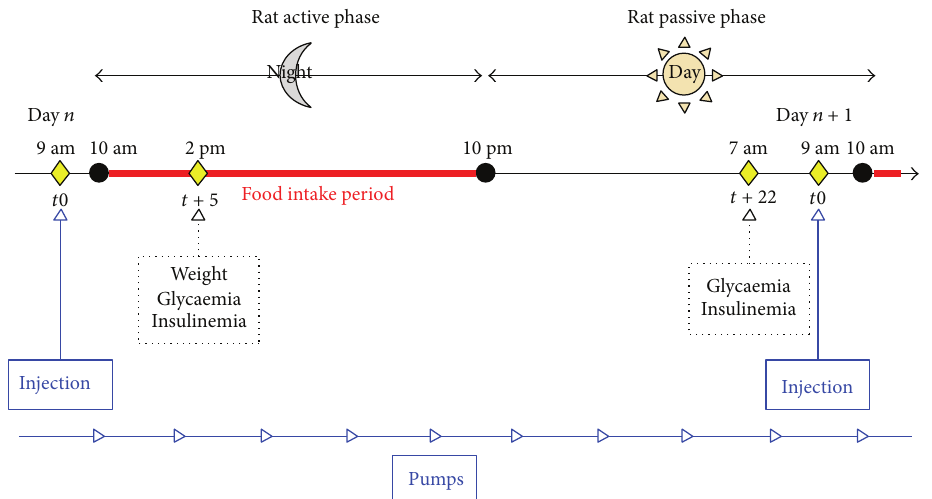
Figure1:Experimentaldailyscheme.Bluerepresentsthetwoinsulinadministrationmodes.Forthesingleinjectiongroup,4 UI/200 gofbody weight of long-acting insulin was administered each day at 9 am. Analyses were carried out at 𝑡+5 and 𝑡+22 h thereafter. For the continuous insulin administration group (via pumps), a rapid-acting insulin was loaded into the osmotic pump to allow a delivery of 4UI/200 g of body weight per day. The injection point 𝑡0 corresponds to 9 am and analyses were carried out at 𝑡 + 5 and 𝑡 + 22 h thereafter.